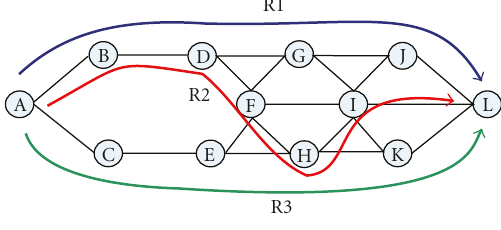
Figure 3: Node-disjoint versus link-disjoint paths.